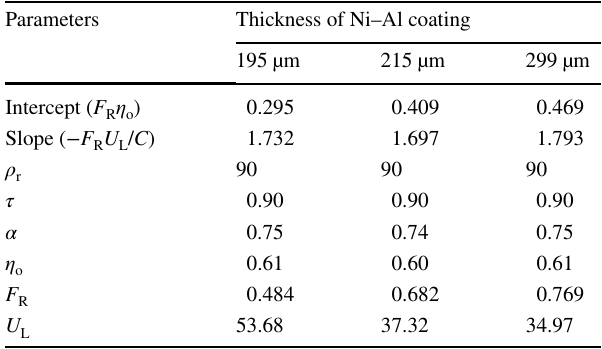
Table 2 Summaries of the thermal performance parameters of the PTC, using the three thicknesses of Ni–Al coating on SS tube as solar absorber of receiver tube Parameters Thickness of Ni–Al